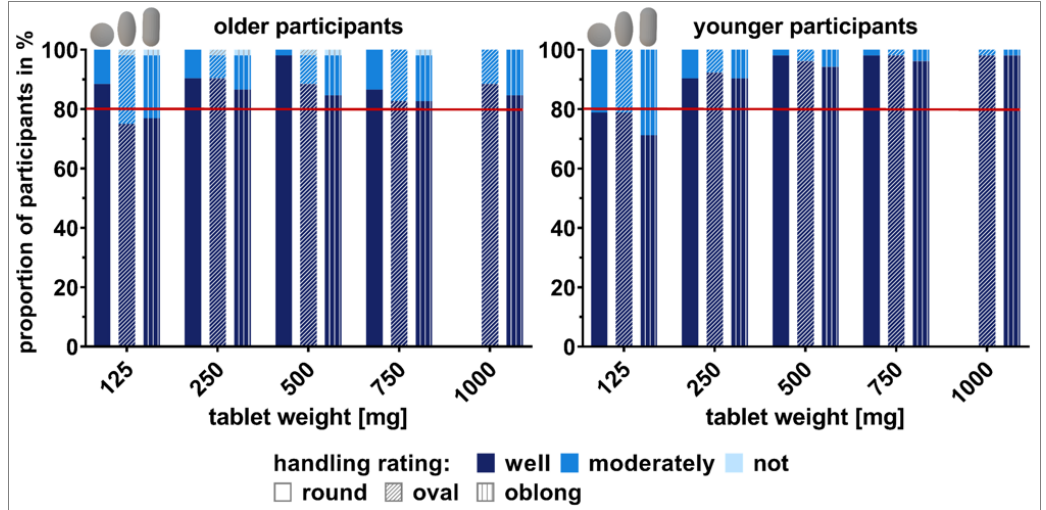
Figure 3. Handling of tablets differing in weight and shape rated as not , moderately, or well to handle . Data are shown separately for the older participants ( left panel) and younger participants ( right panel). Each participant gave a rating for every tablet. The value of 80% was used as a cutoff value for the data evaluation as it is a commonly used threshold for acceptability.